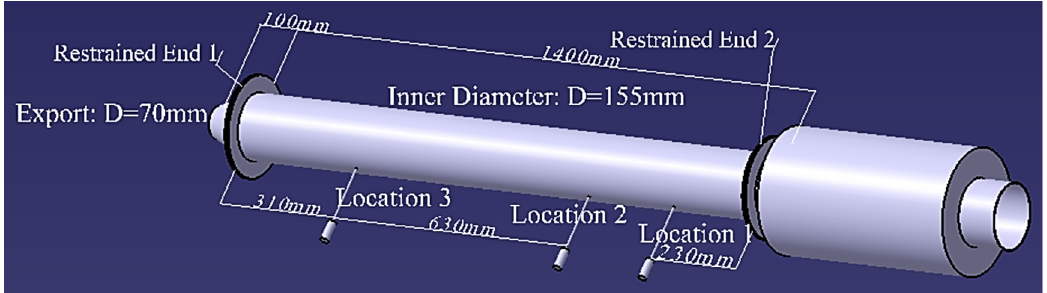
Figure 6. Cylindrical cavity fluid-solid coupling experimental model and schematic diagram of dimension measuring points.